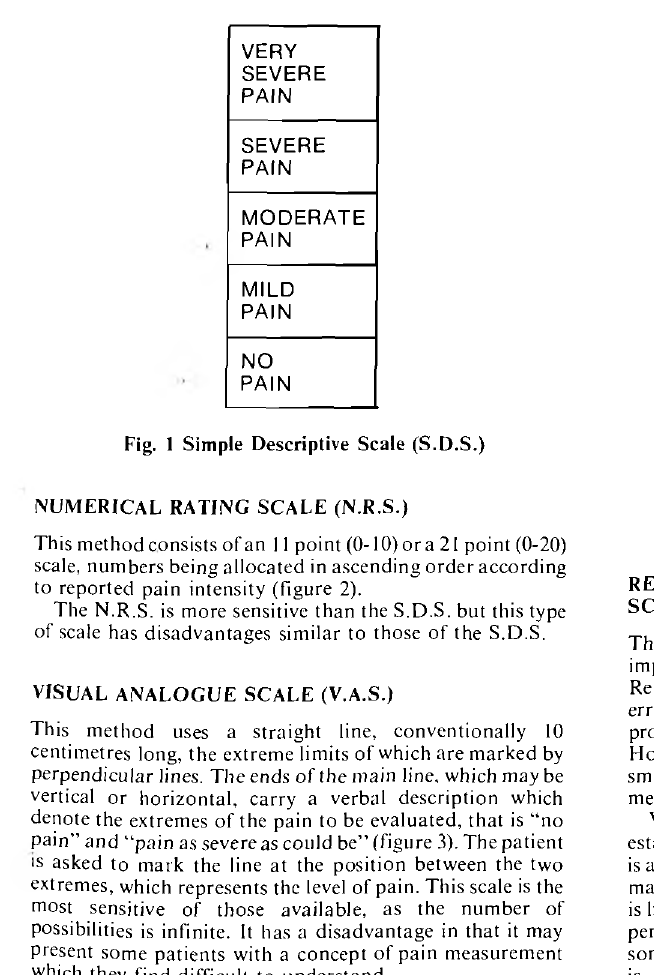
Fig. 2 Numerical Rating Scale (N.R.S.)